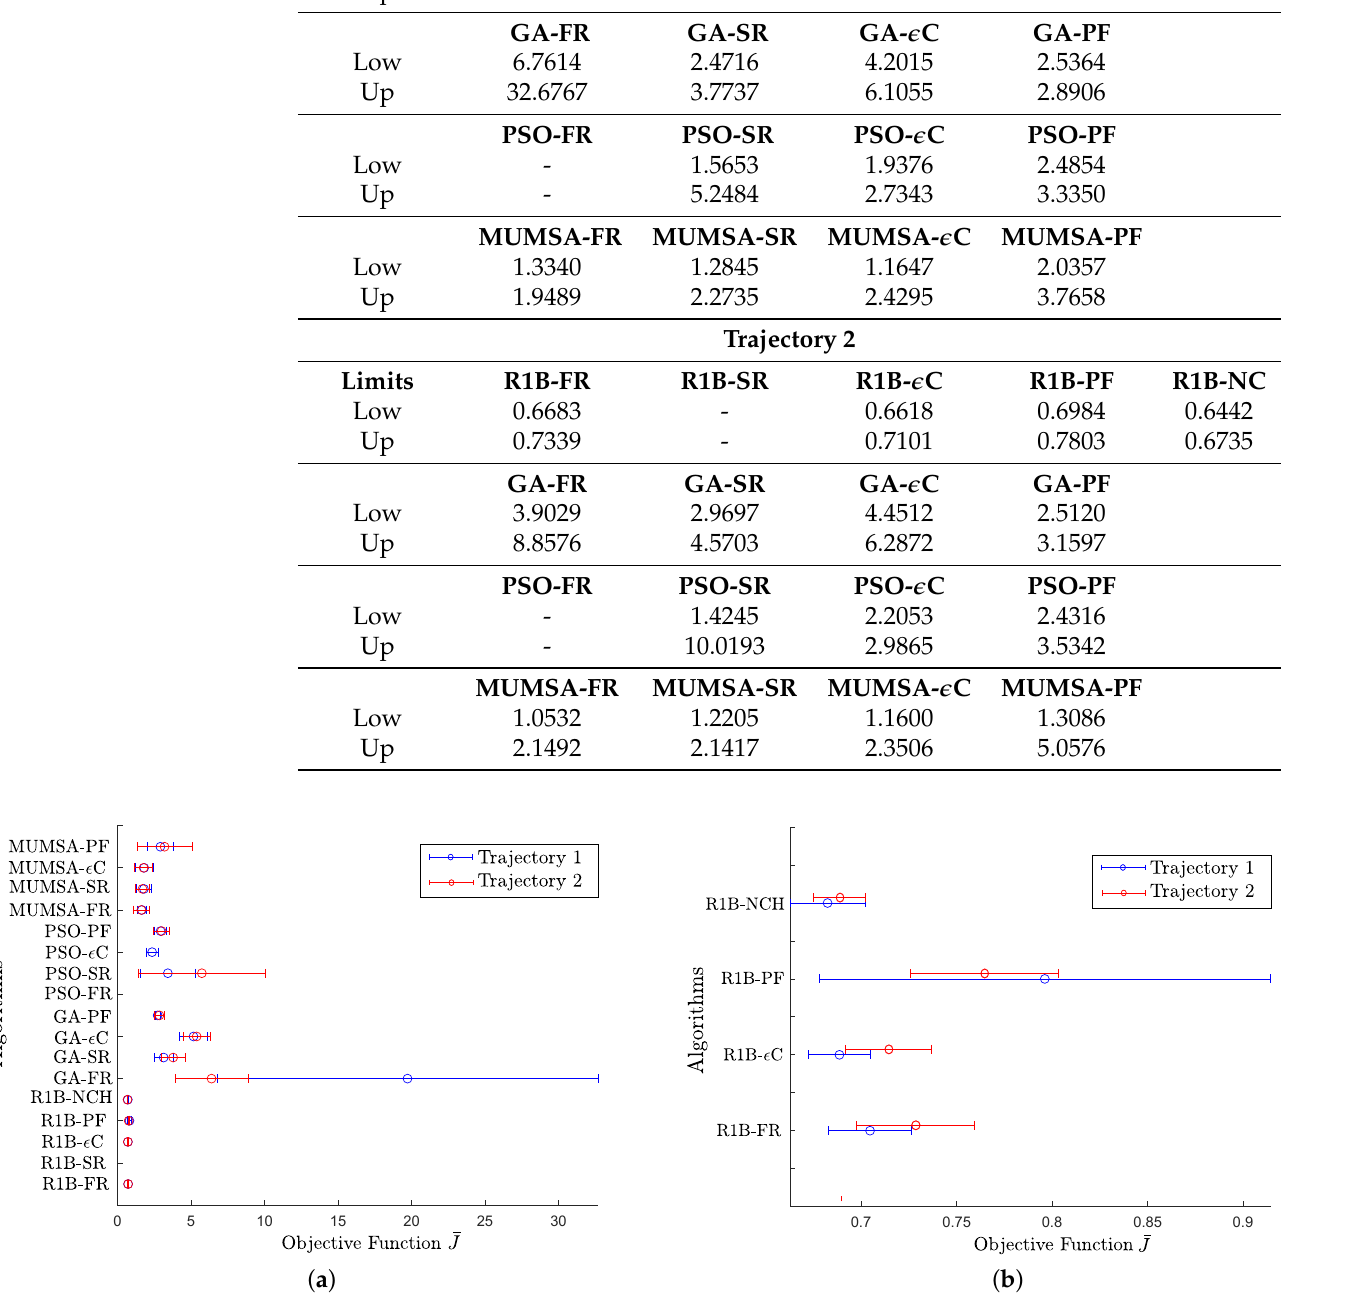
Figure 8. Graphical representation of confidence intervals for algorithms solving the study case 2 in both trajectories. ( a ) Original size. ( b ) Close − up